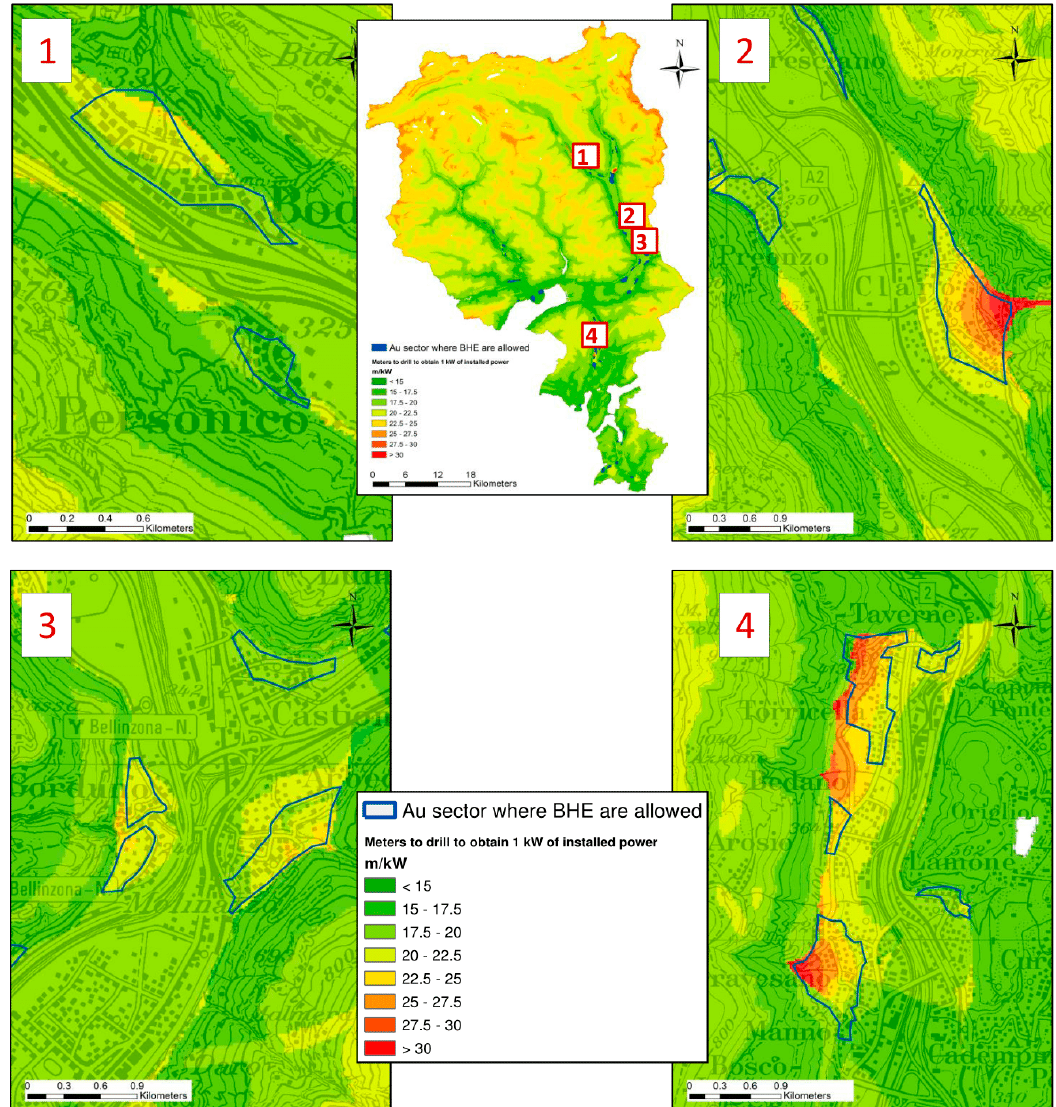
Figure 9. Comparison in some test areas between shallow geothermal potential expressed as m/kW and areas where the installation of new BHE is